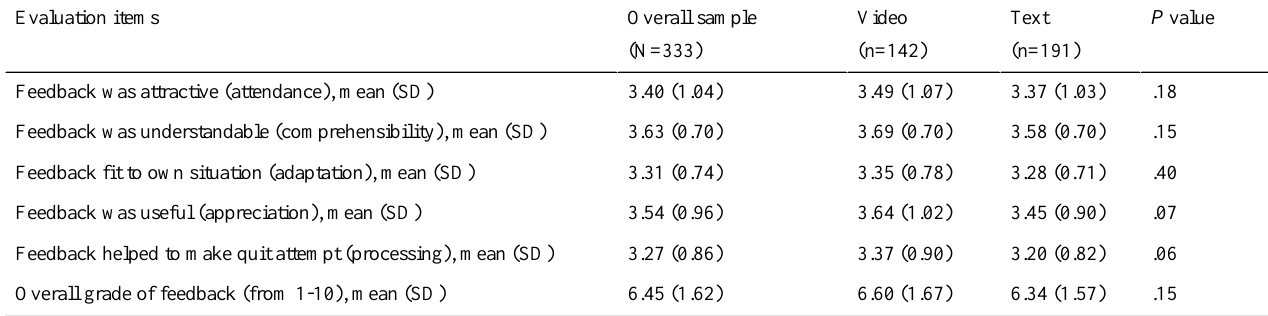
Table 6. Means and standard deviations (SD) for evaluation of different aspects of the video-based and text-based computer tailoring intervention programs at 6-month